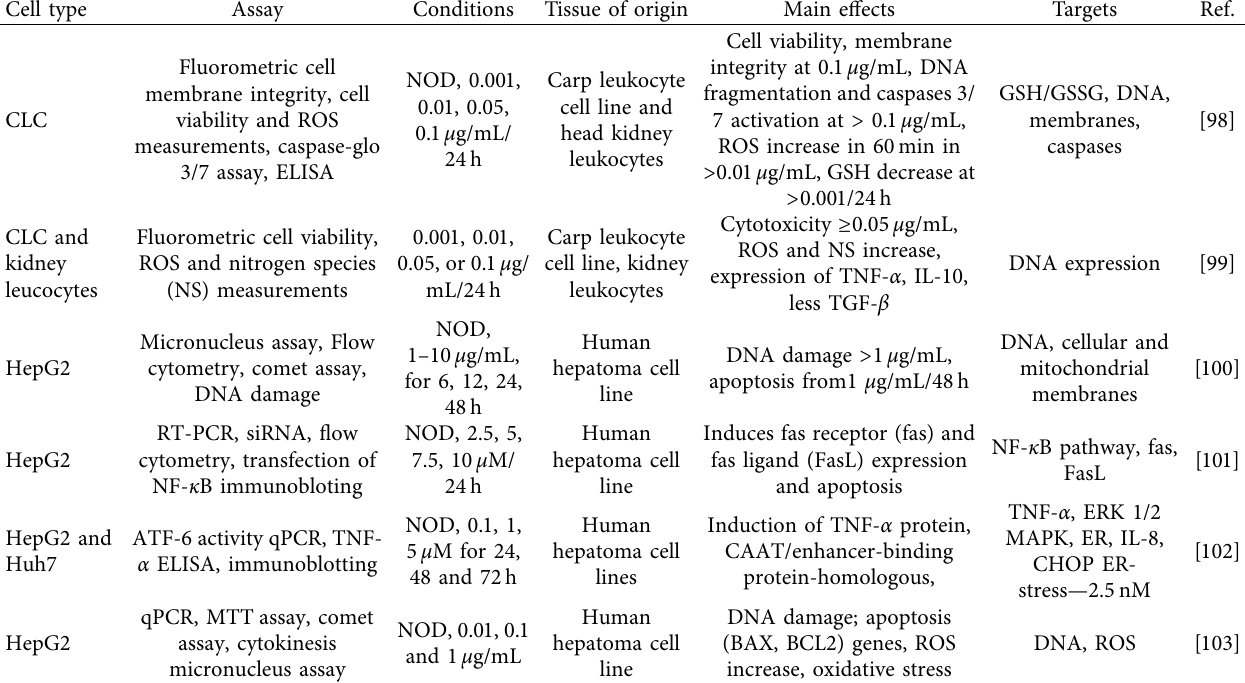
Table 9: Cytotoxicity of